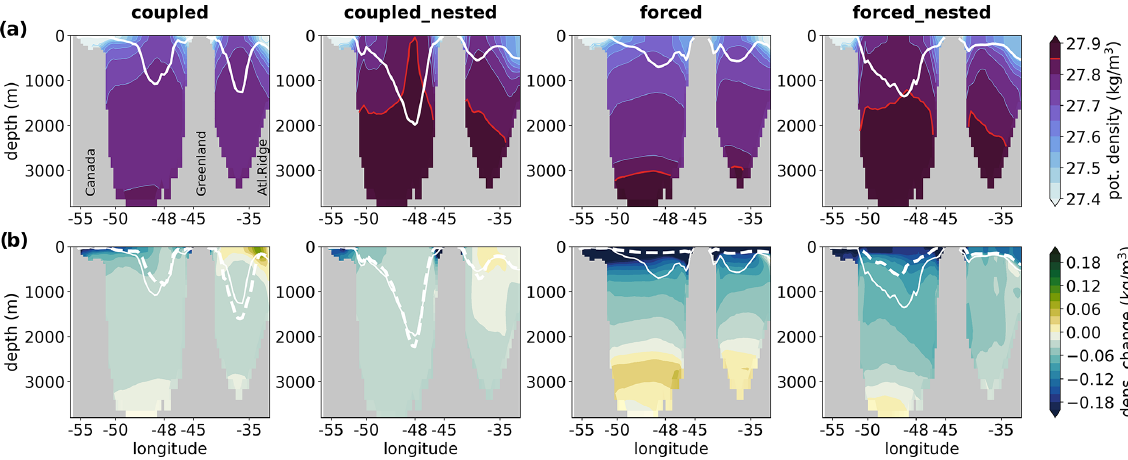
Figure 10. Cross-section through Labrador and Irminger seas showing (a) March-mean potential density ( σ 0 ) and (b) the change due to the freshwater perturbation. The solid and dashed white lines depict the March-mean mixed-layer depth of the reference and perturbed states, respectively. The red contour in panel (a) highlights densities > 27.85kgm − 3 . The cross-section follows the location of the OSNAP line (see Fig. 8).